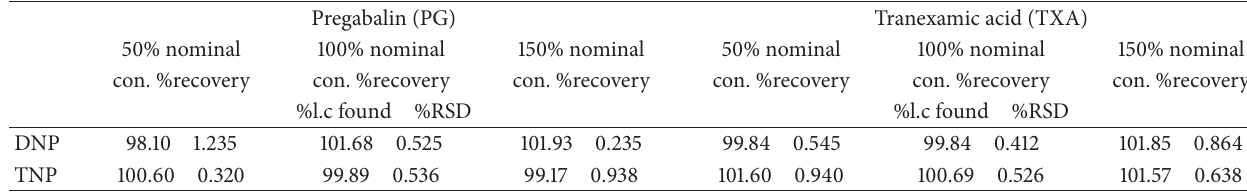
Table 3: Accuracy and precision.